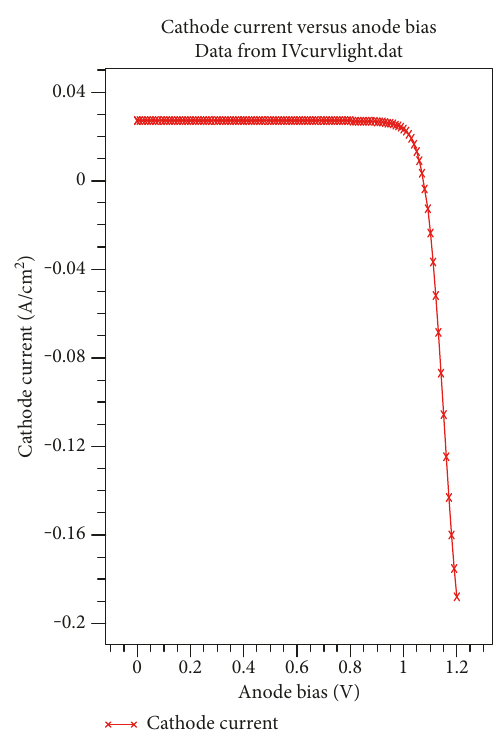
Figure 9: I - V characteristics of the optimized solar cell.